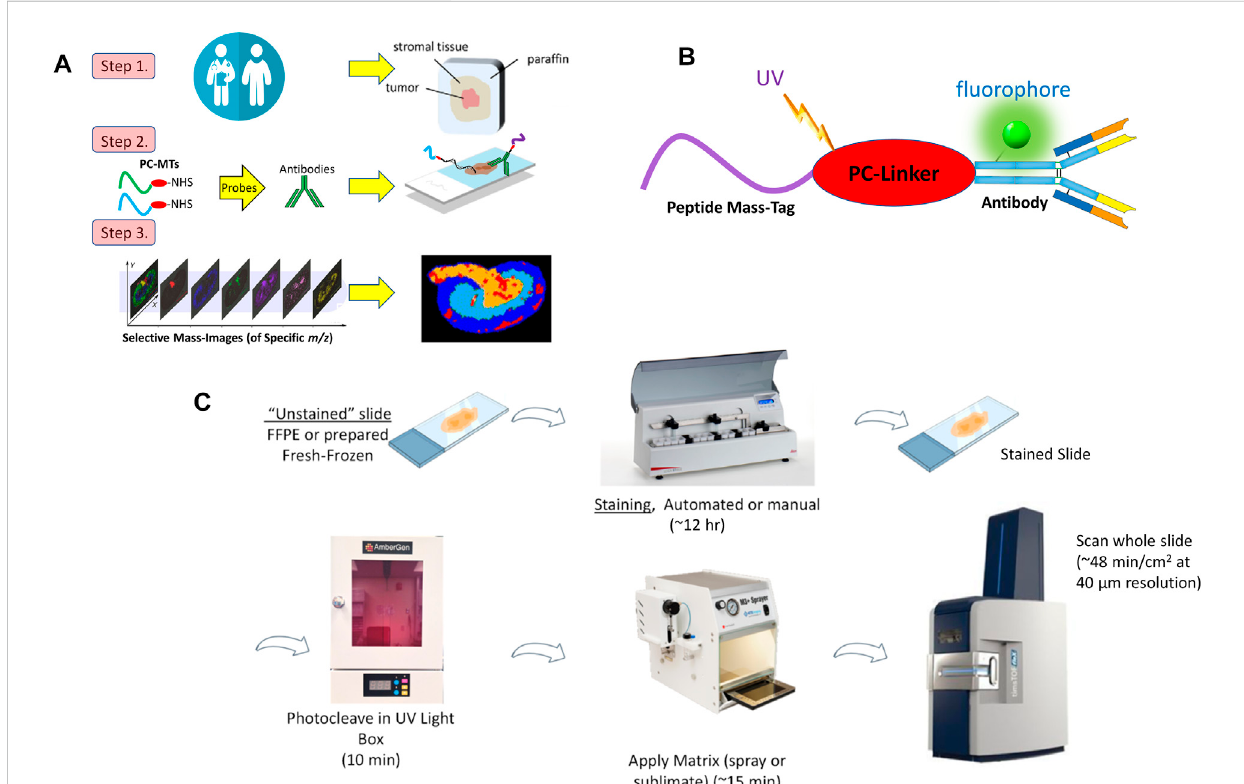
FIGURE 1 (A) . Key steps in MALDI-IHC. Photocleavable Mass-Tag (PC-MT) labeled probes, including antibodies and lectins, are used for high-plex tissue imaging. An additional initial step (not shown) can be performed prior to MALDI-IHC to image endogenous small molecules such as metabolites and drugs (See main text for details). (B) . Schematic of a dual-labeled Miralys ™ antibody probe with a photocleavable peptide mass-tag and fl uorophore conjugated to the antibody. Note the diagram does not re fl ect the actual attachment sites of the peptide mass-tag or fl uorophores, or the actual number of tags conjugated to the antibody. (C) . Example MALDI-IHC work fl ow. Both FFPE and FF tissue samples can be imaged using MALDI-IHC. StainingutilizesMiralys ™